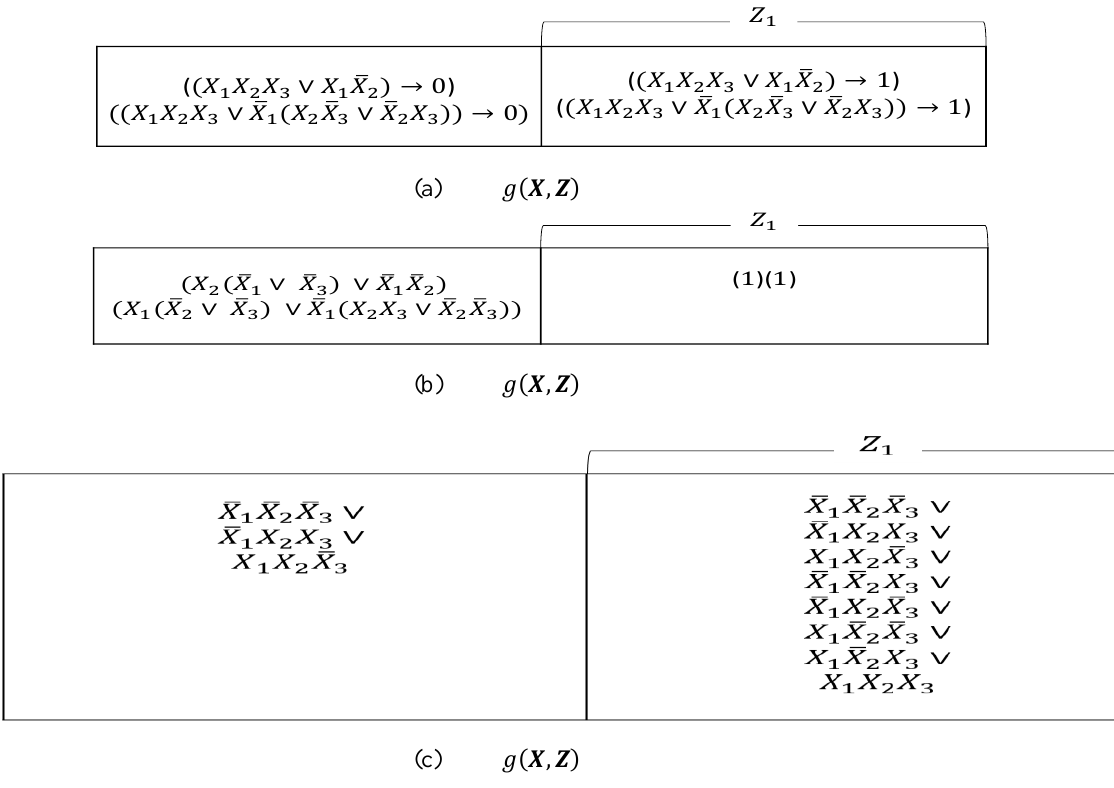
Fig. 15. Gradual development of the natural map for 𝑔(𝑿, 𝒁) obtained by suppressing 𝒀 from ℎ(𝑿, 𝒀, 𝒁) in Fig. 14